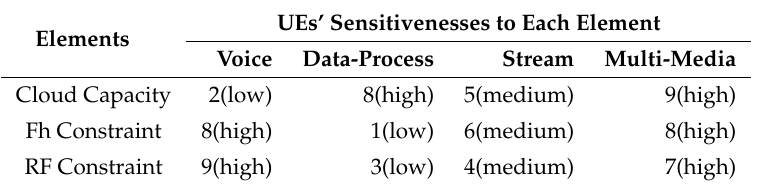
Table 1. UEs’ sensitivenesses to cloud selection related